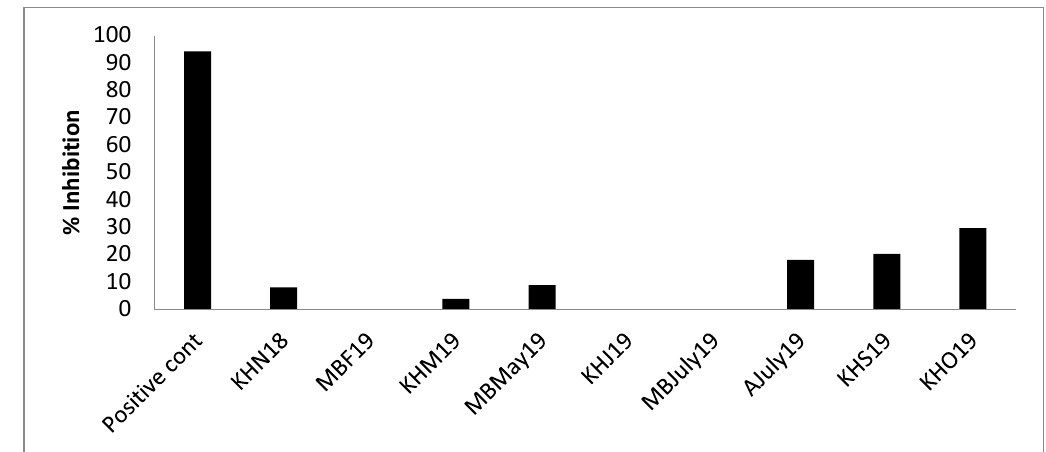
Figure 8. AChE enzyme inhibition (%) by inhibition by mussel Protamex ® hydrolysates. Nine samples from the three sampling sites, Mulroy bay (MB), Killary harbor (KH) and Ardgroom (A), collected from November 2018 to October 2019, were used for analysis at a concentration of 1 mg/mL. *The positive control showed significantly higher AChE inhibition as compared to all the samples. Assays were performed in triplicate (n = 3).